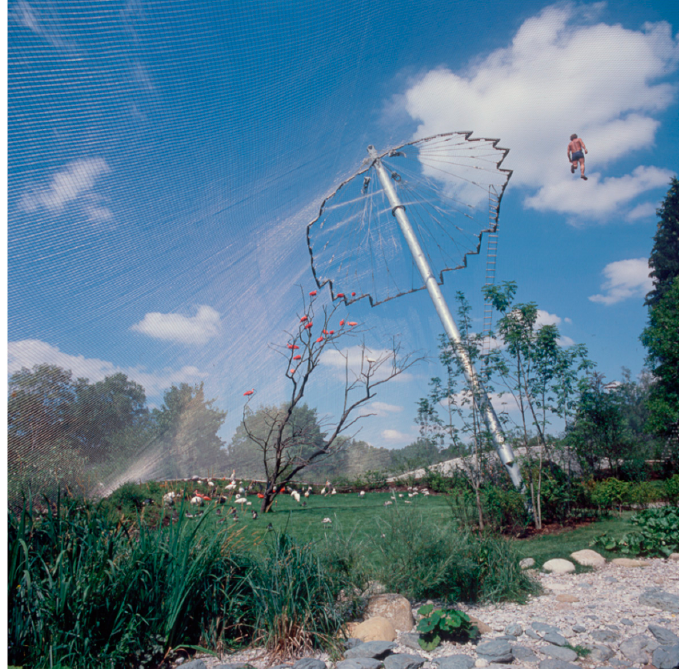
Figure 4. Jörg Griebl and Frei Otto, aviary of the Munich Zoo Tierpark Hellabrunn, 1979–1980. Photograph by Frei Otto, July 1980. © saai|Südwestdeutsches Archiv für Architektur und Ingenieurbau am KIT Werkarchiv Frei Otto.